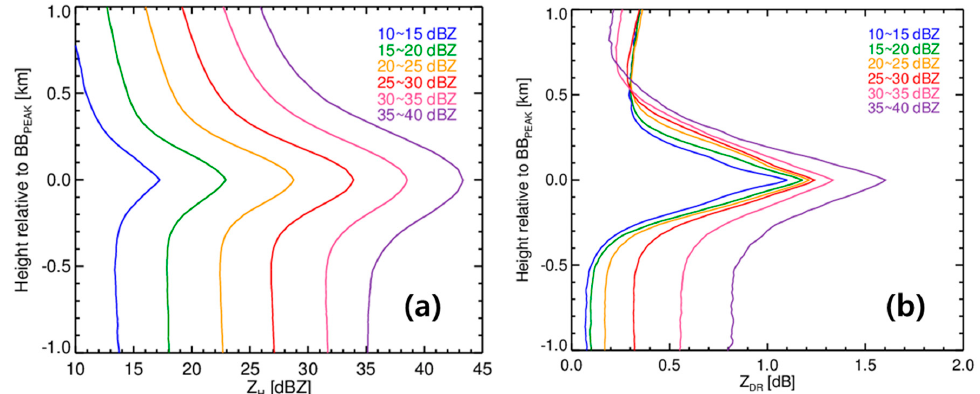
Figure 14. Mean profile of the ( a ) Z H and ( b ) Z DR with respect to the height relative to BB PEAK at the Z H Bottom classes with 5 dBZ intervals.